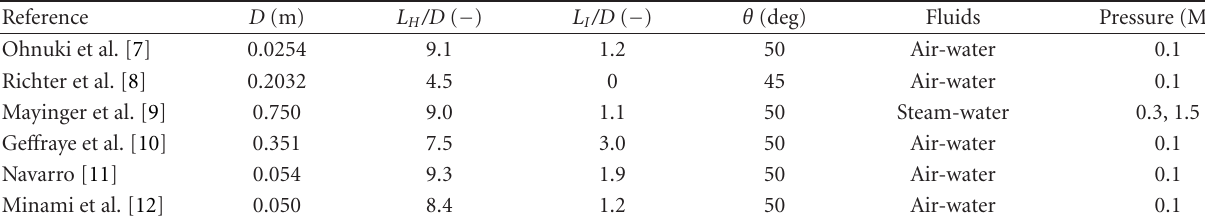
Table 1: Test section dimensions and conditions.